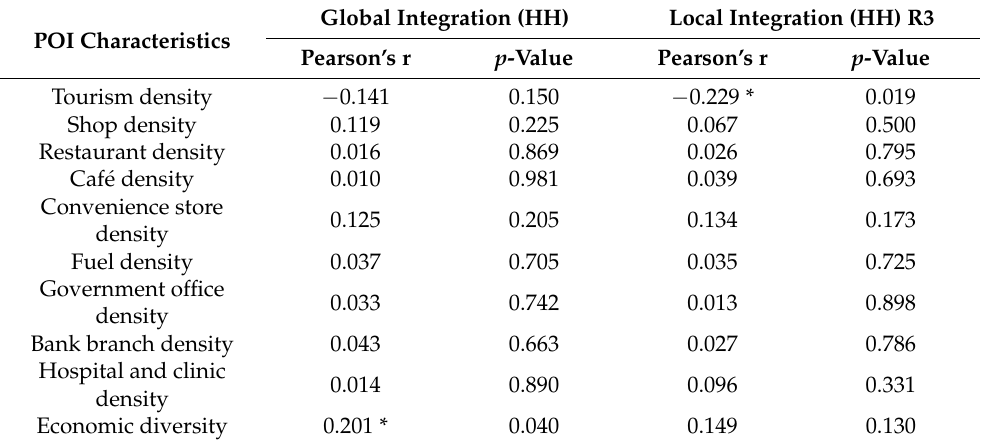
Table 2. Pearson correlation coefficients between the points of interest characteristics and integration